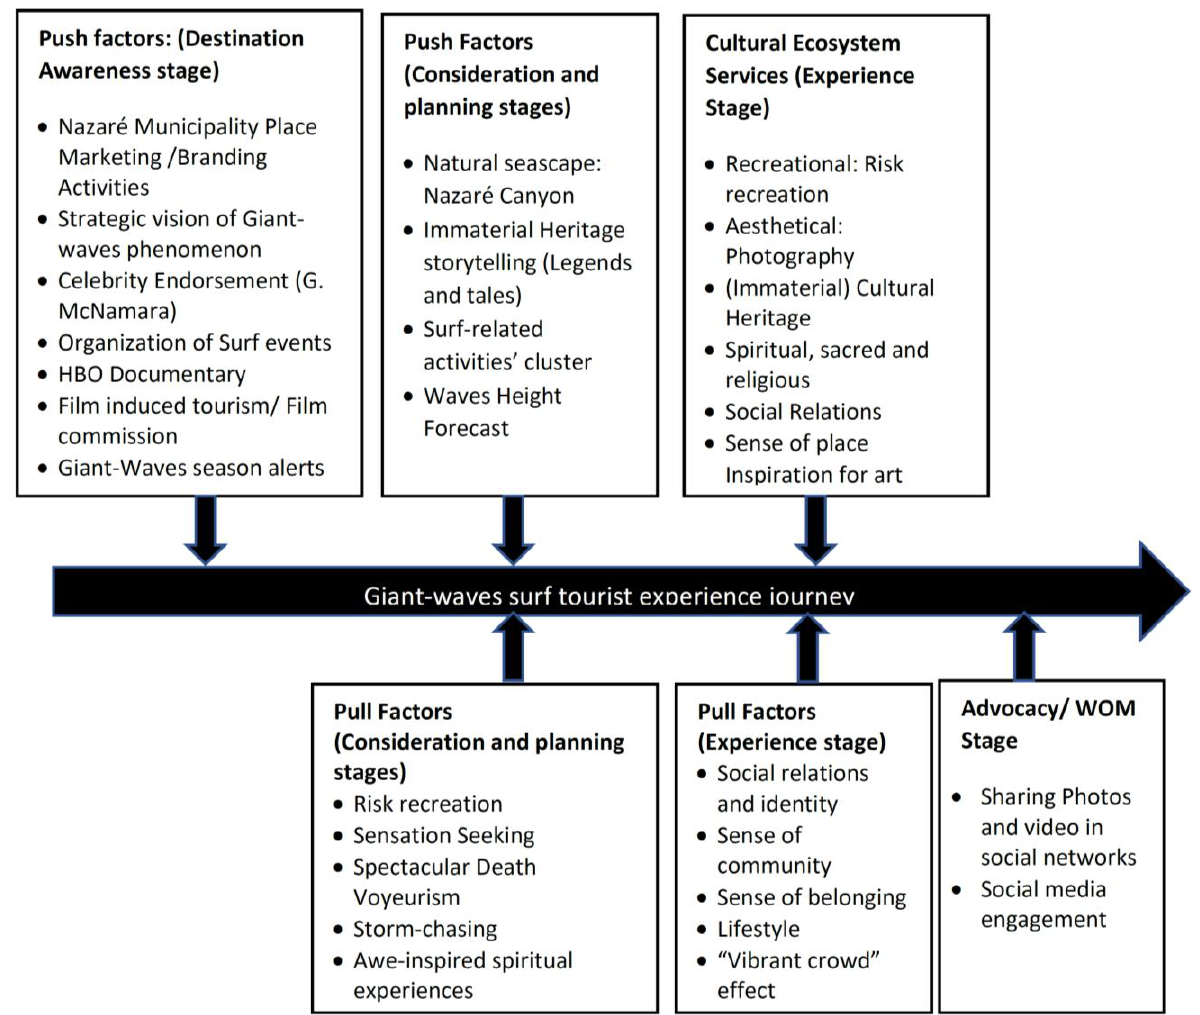
Figure 7. Theoretical framework of a tourist ’s experience journey of the giant-wave spectator/chaser.